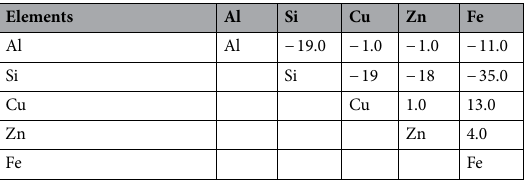
Table 3. Enthalpy of mixing (kJ/mol) of binary elements 31,32,35,38,39 .